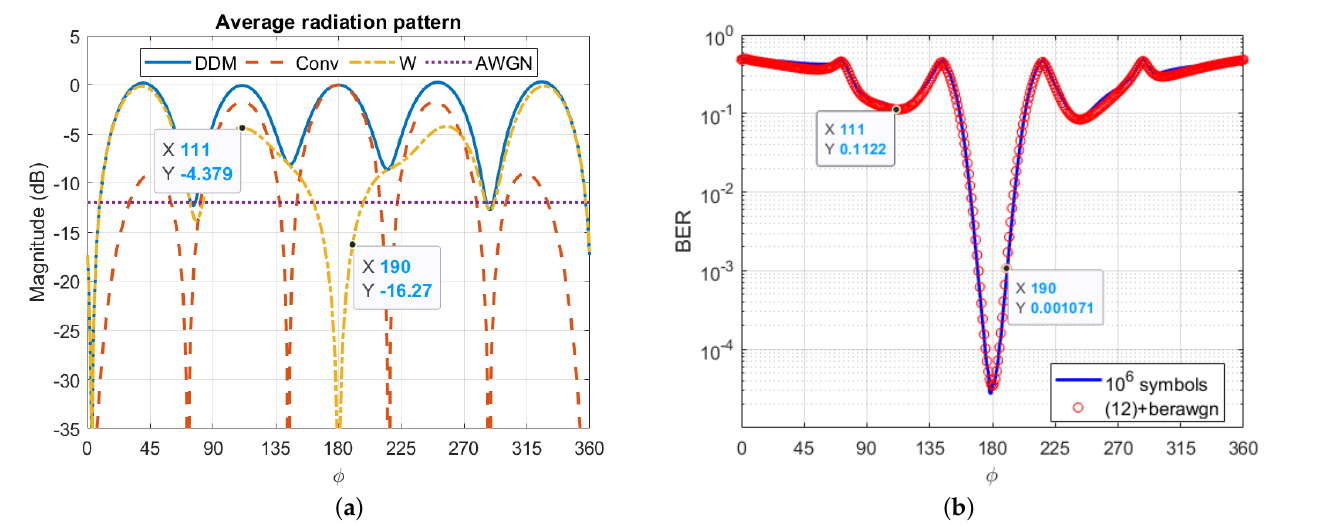
Figure 10. Compact antenna of [37]. QPSK modulation, φ 0 = 180 ◦ , SNR( φ 0 ) = 12 dB, PE DDM = 45%, P = 64. Zero-mean artificial non-Gaussian noise. Average radiation pattern ( a ) and BER ( b ) in the XY